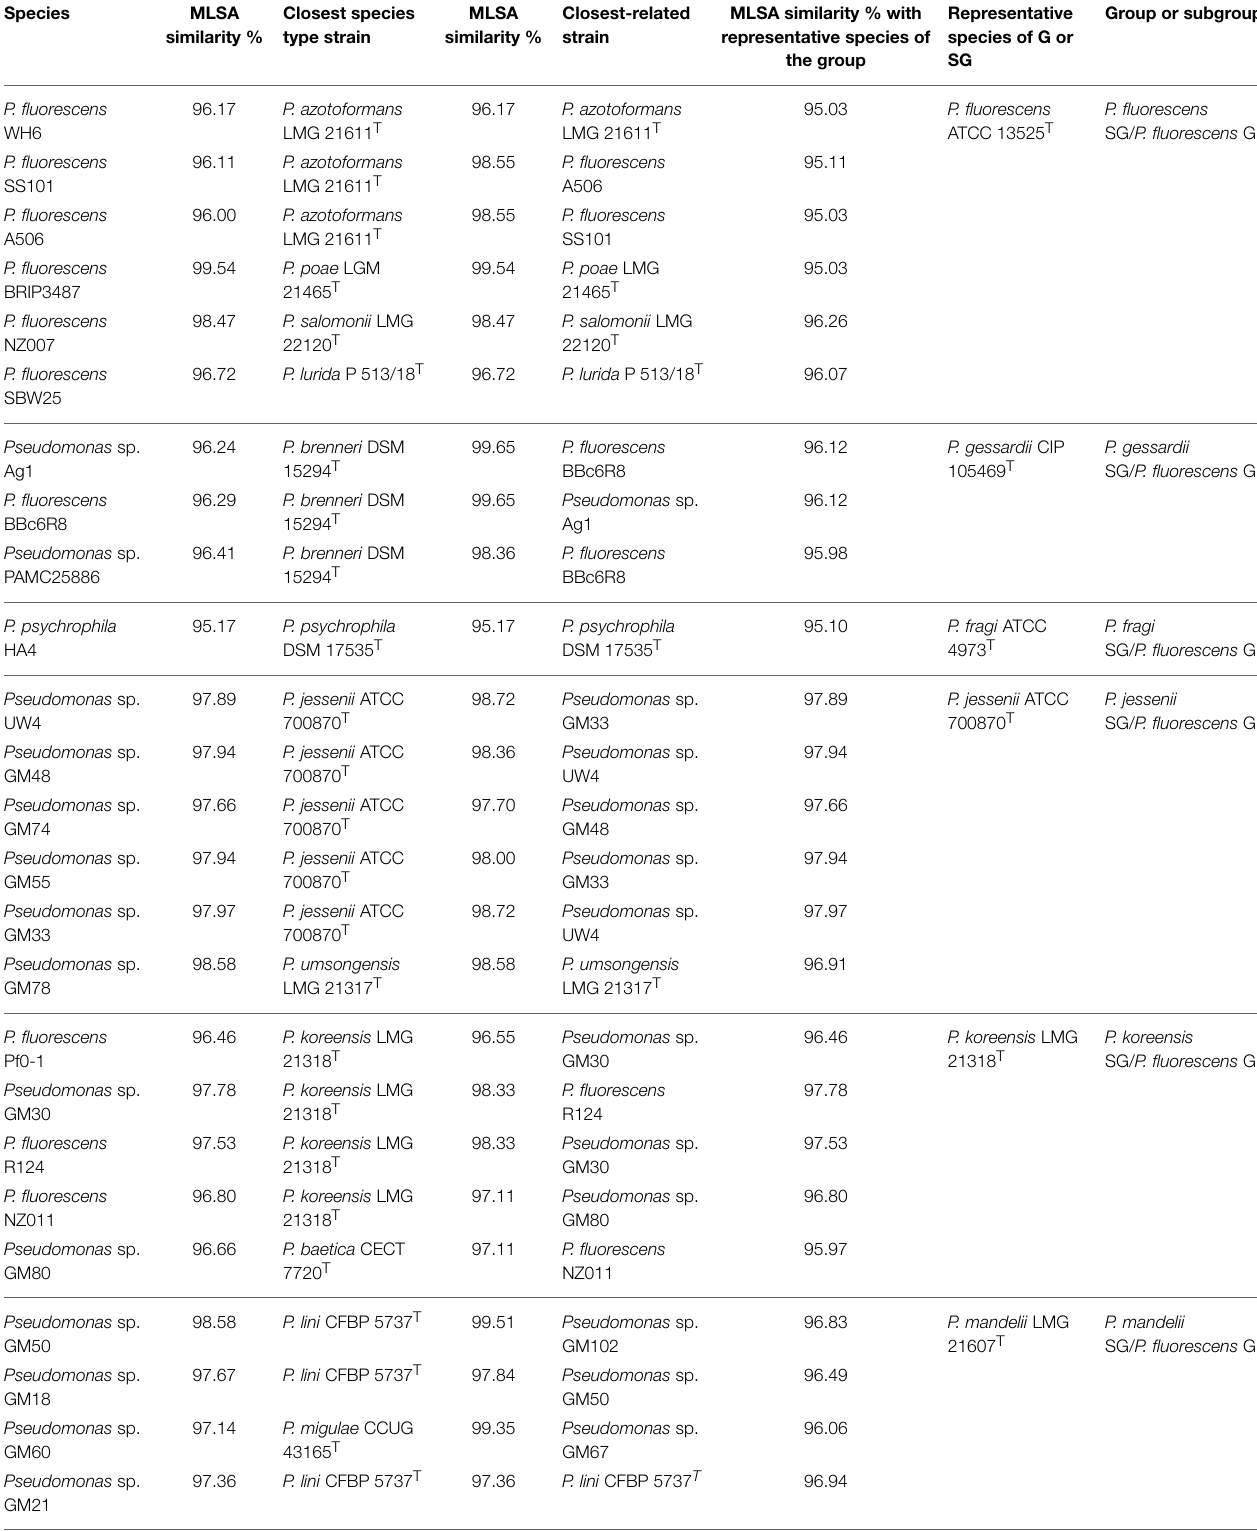
TABLE 1 | Phylogenetic affiliation based on concatenated MLSA analysis for the 63 whole genome sequenced strains not assigned, or incorrectly assigned at the species level, including strains of P. stutzeri genomovars.